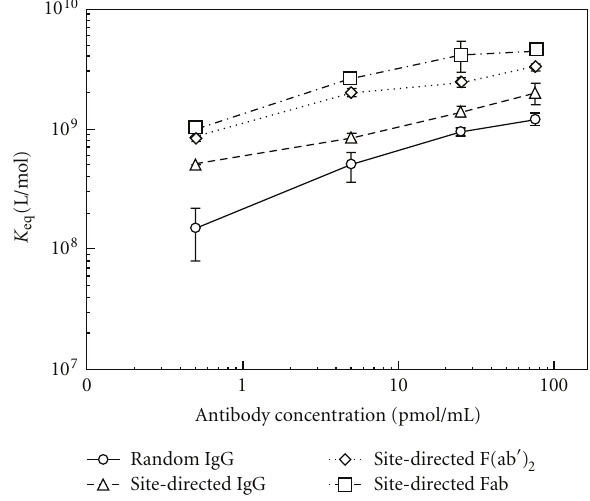
Figure 4: Comparison of the reactive antibody densities immo- bilized on the solid surfaces via biotin-streptavidin linkage. At a constant concentration of antibody, the reactive antibody density was determined by means of Scatchard analysis. The same pro- cedure was repeated with di ff erent antibody preparations of IgG, , and Fab. Standard deviations of triplicate repetition for F(ab (cid:2) ) 2 each measurement were shown.